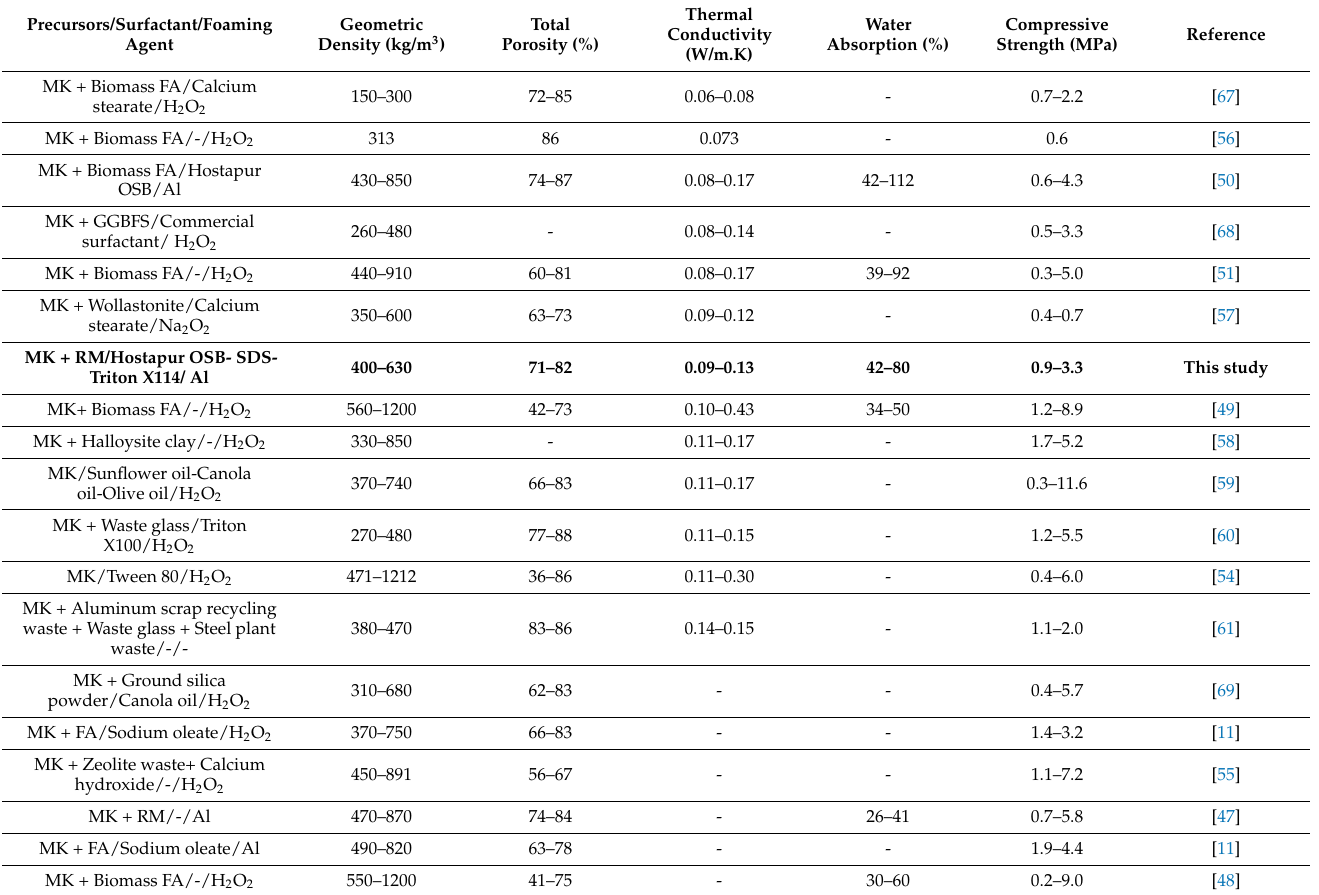
Table 4. Comparison of GFs’ results with previous